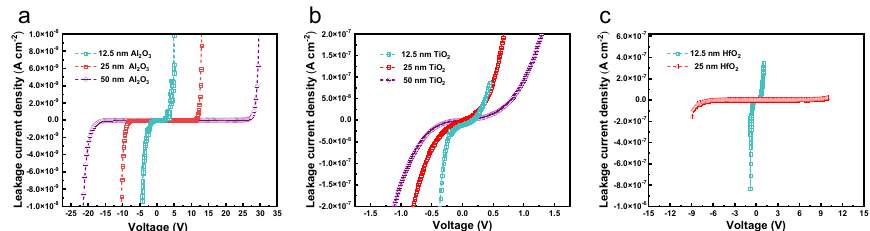
Figure 4. The relationship between leakage current density and applied voltage of manufactured MIM capacitors with different dielectric materials and thicknesses. ( a ) J - V characteristics of Al 2 O 3 dielectric MIM capacitors. ( b ) J - V characteristics of TiO 2 dielectric MIM capacitors. ( c ) J - V characteristics of HfO 2 dielectric MIM capacitors.